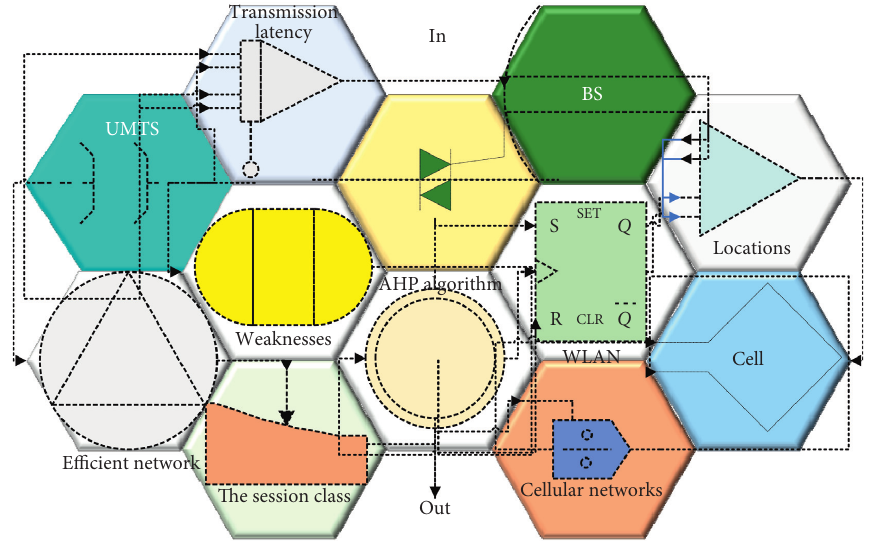
Figure 1: Heterogeneous wireless network system